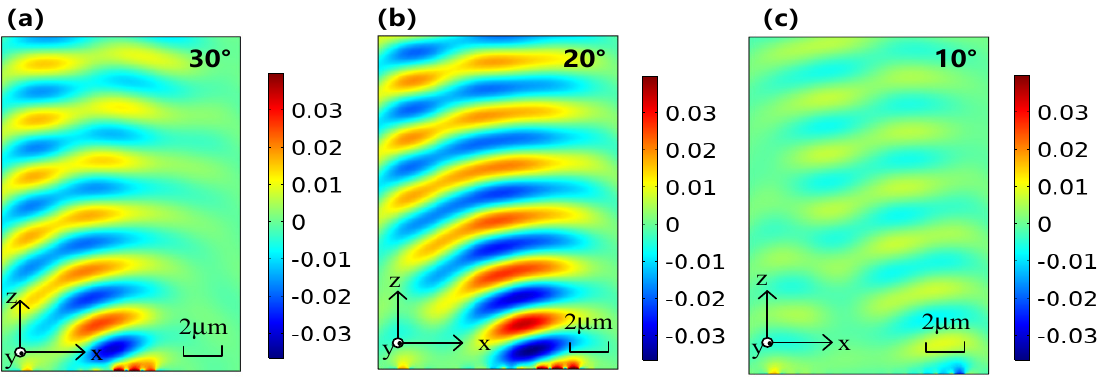
Figure 4. The simulated distributions of the electric field for tunable antennas capable of dynamical angular beam steering toward ( a ) 30 ◦ , ( b ) 20 ◦ , and ( c ) 10 ◦ , respectively. The scale bar is shown in the subfigure. 1 cm on the picture represents the actual distance of 2 µ m. The legend represents the magnitude of the electromagnetic field. The polarization direction of the electric field is the z − direction.